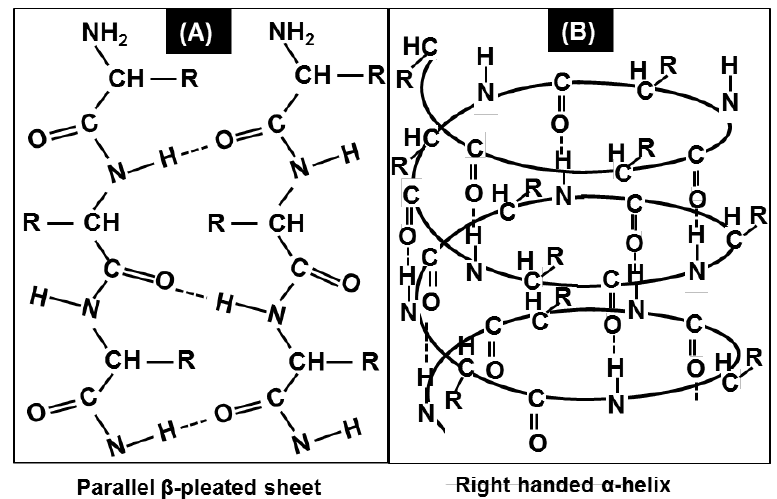
Figure 4. Understanding the protein secondary structures and physics of IR interaction. ( A ) Parallel β -pleated sheet structure of proteins. N-H groups in the backbone of one strand form hydrogen bonds with the C = O groups in the backbone of the adjacent strand to form a β -sheet. ( B ) Right-handed α -helix structures of proteins. The backbone N-H group donates a hydrogen bond to the backbone C = O group, contributing to the helical structure of the α-helix.